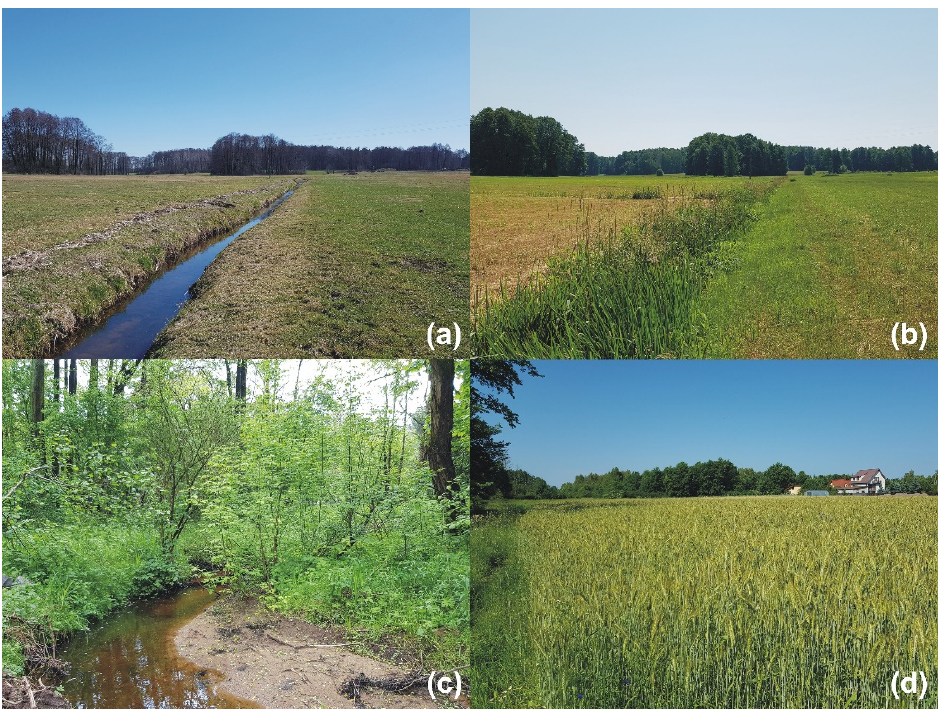
Figure 2. The channel of the Sienniczanka stream (T4) during spring ( a ); the same sampling site during summer, overgrown mainly by Sparganium erectum L. ( b ); the channel of the Ostrowik stream (T12) shaded, with the forest consisting of Populus tremula L. and Alnus glutinosa (L.) Gaertn. ( c ); a typical agricultural landscape with common wheat crops 10 meters from site T13 ( d ).